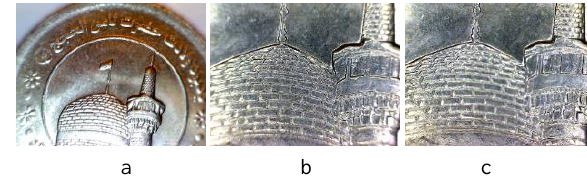
Figure 2. Different focuses in different parts of the surface of a coin. a) View of the coin. b and c) Different focuses on the coin